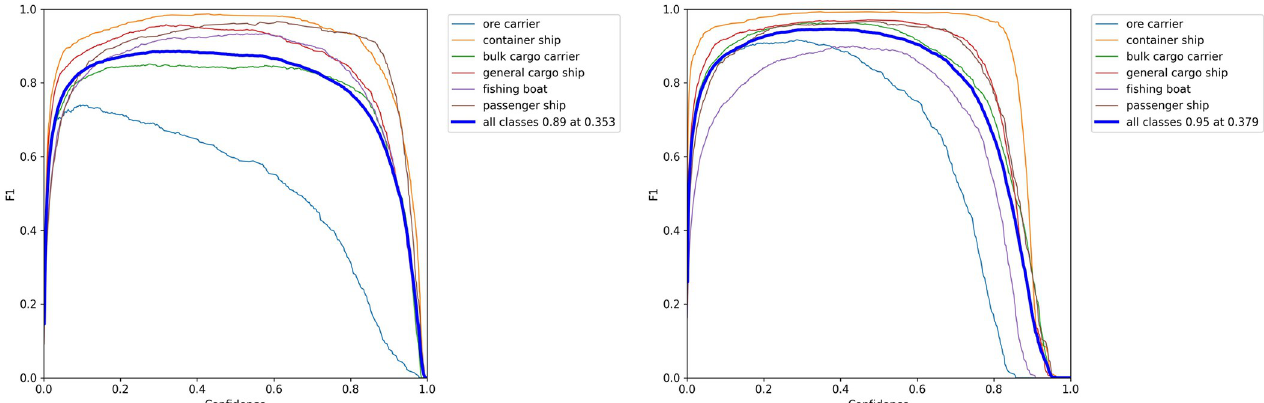
Fig 14. F1 fraction curves for different types of ships. (a) YOLOv5s (b) MC-YOLOv5s.